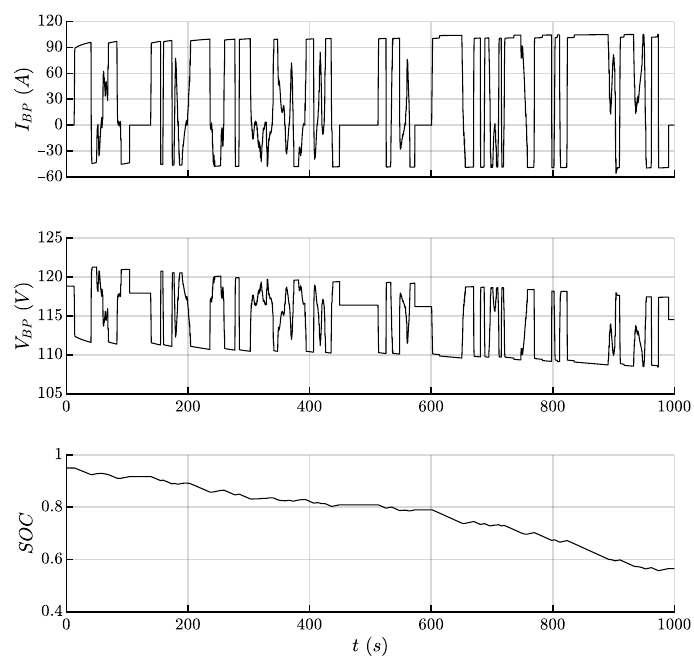
Figure 5. Battery pack current, battery pack voltage, and state of charge.